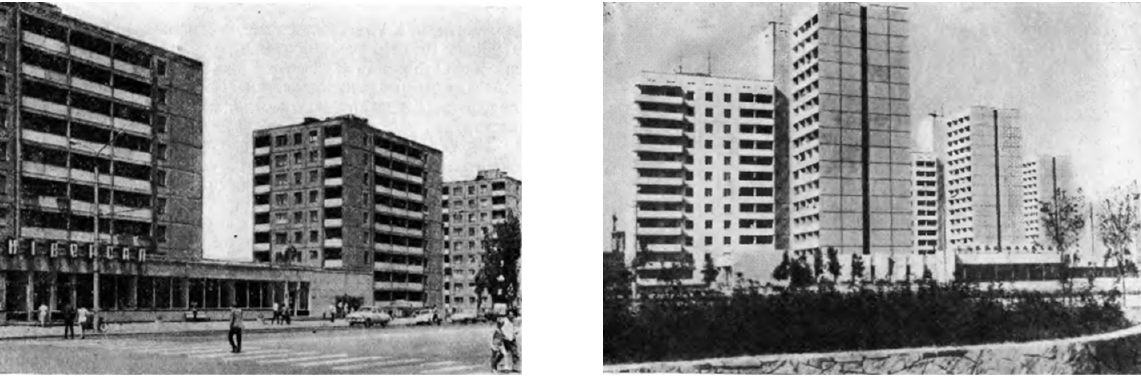
Figure 2. Historical images of the development of Dnipro city with large-panel buildings of series